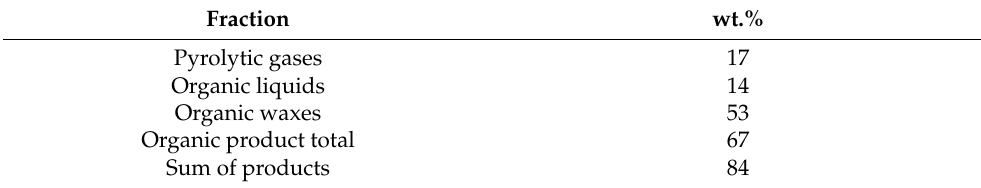
Table 1. Product yields for gases, liquids, and waxes from the pyrolysis of polypropylene. Fraction